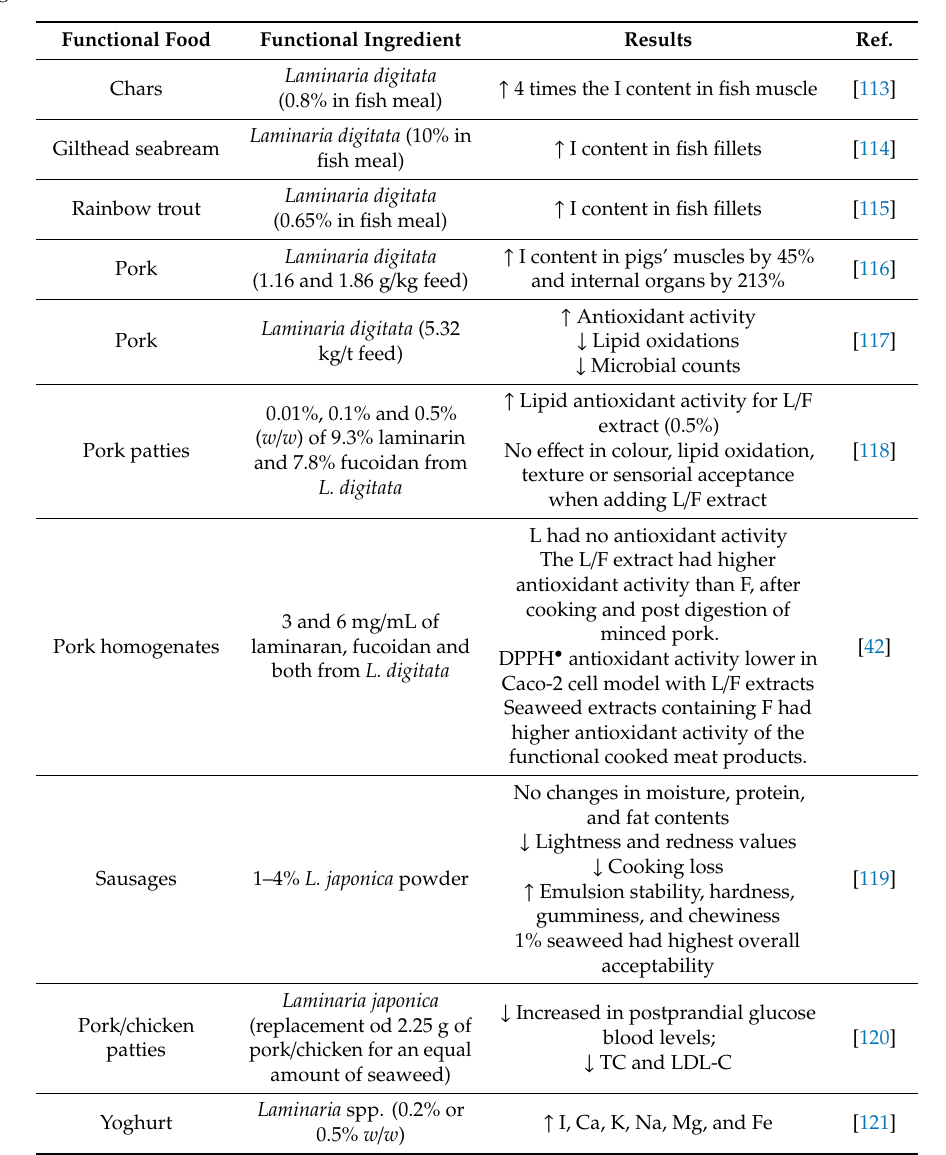
Table 5. Selected studies reporting the e ff ects of the incorporation of Laminaria sp. or isolates as ingredients in di ff erent food